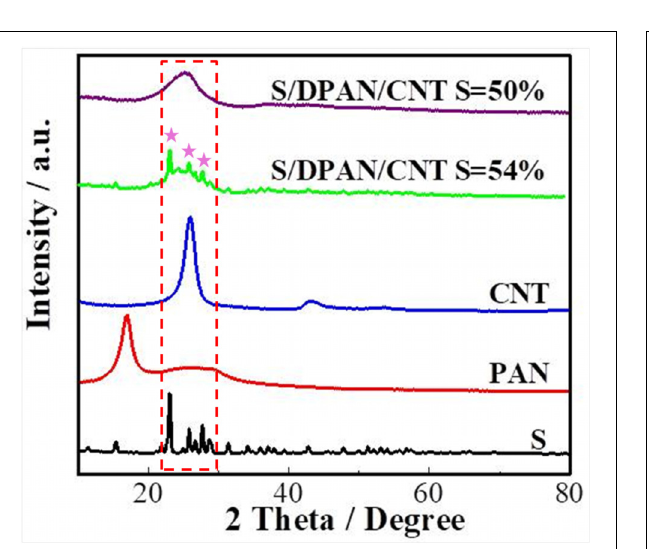
FIGURE 3 | XRD results of S/DPAN/CNT composites.